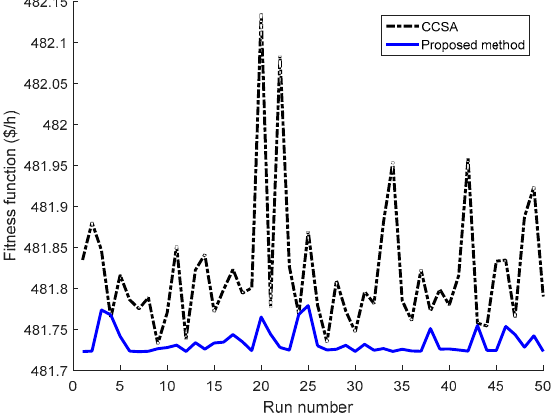
Figure 5. Fitness function of 50 runs obtained by the CCSA and proposed method in case 1.1.